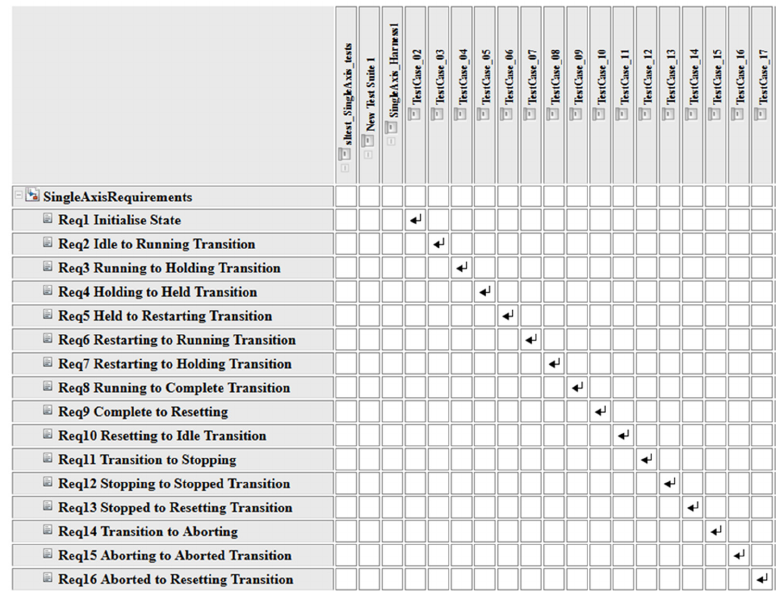
Figure 12. Requirements Traceability Matrix displaying the Links between each requirement (left) and its corresponding test case (top), with the soft return figure identifying the link.